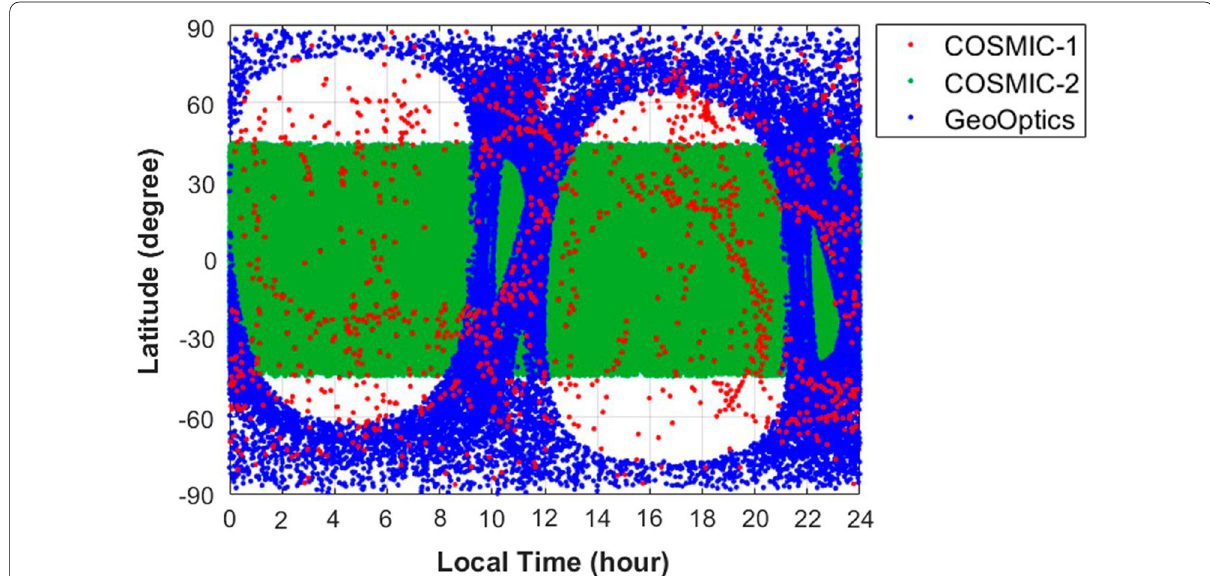
Fig. 4 Local time–latitude distributions of radio occultation measurements for COSMIC-1 (red dots), COSMIC-2 (green dots) and GeoOptics (blue dots)